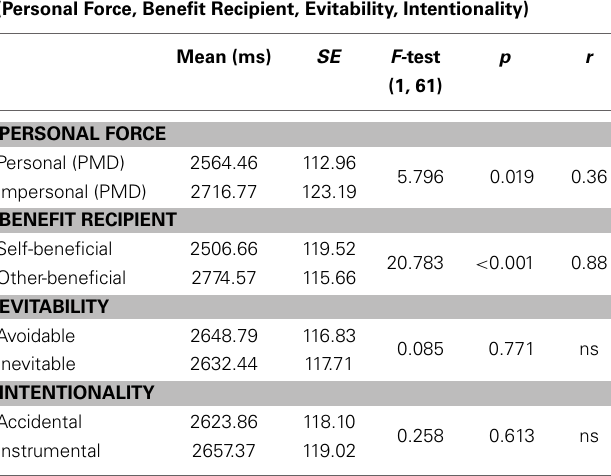
Table 3 | RM ANOVA of the RT of the arousal ratings. RM ANOVA—Main effects on RT